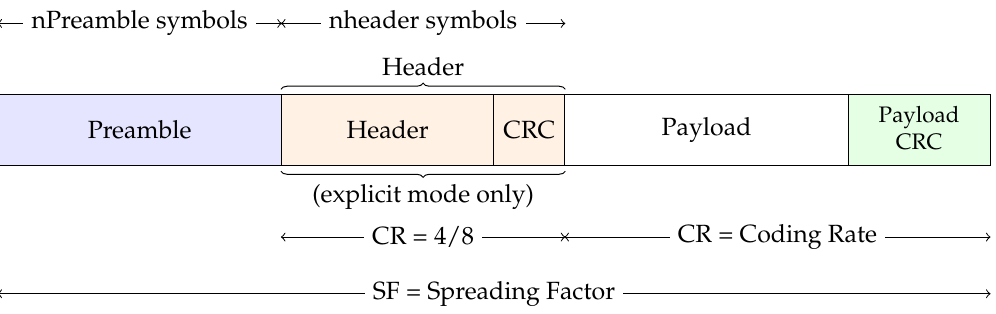
Figure 1. Longe Range (LoRa) uplink packet